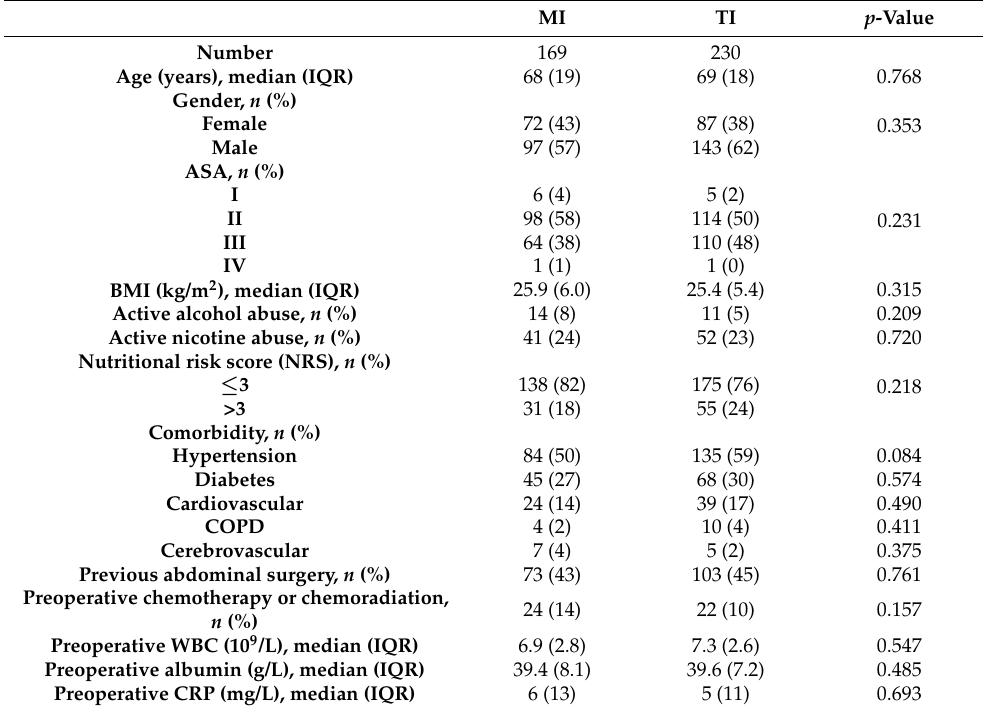
Table 1. Characteristics of patients undergoing pancreatoduodenectomy ( n = 399) stratified by incision type (MI (midline incision) vs. TI (transverse